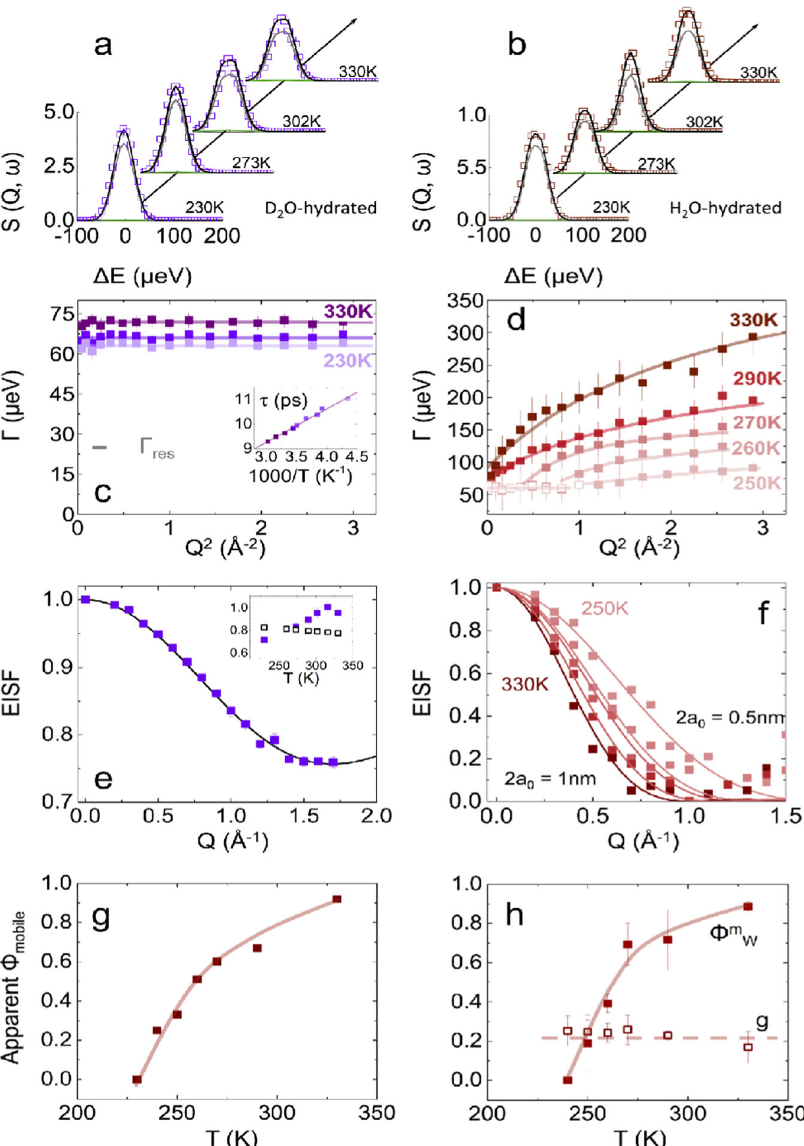
Fig. 4 Hydrated (vapor) PA analysis of QENS data. S ( Q , ω ) data and model fi t, measured by TOF, at 45 μ eV resolution, for the PA hydrated polymer in ( a ) in D 2 O and ( b ) H 2 O vapor, at selected Q = 1.5 Å − 1 and temperatures indicated. c HWHM for PA hydrated polymer relaxation (and associated times in inset) measured in D 2 O, at selected temperatures and ( d ) of the water translational dynamics, measured from the second Lorentzian pro fi le; the gray horizontal line shows the (half) instrumental resolution ( Γ res = 22.5 μ eV). The error bars correspond to the fi tting uncertainties of the linewidth. e EISF accounting for the mobile protons fraction at 330 K, for the out-of-plane, two-state fl ip depicted in Fig. 2c – e (detailed in Supplementary Note 5: Model 2), showing the fraction of mobile protons in the inset. f EISF for the diffusion of water molecule inside of a sphere or radius a , computed from the water signal in the PA hydrated by H 2 O vapor (second Lorentzian) and Eq. (8) (detailed in Supplementary Note 6: Model 3). g Overall, apparent proton mobile fraction computed from the TOF signal of hydrated PA. h Fraction ϕ m of water molecules undergoing tr diffusion, and g fraction of those which undergo both lr and W tr diffusion. The error bars correspond to the maximum range compatible with the data and model employed. Source data are available at https://doi.org/ 10.5291/ILL-DATA.9-11-1809 and https://doi.org/10.5291/ILL-DATA.9-11-5311718, and provided as a Source Data fi